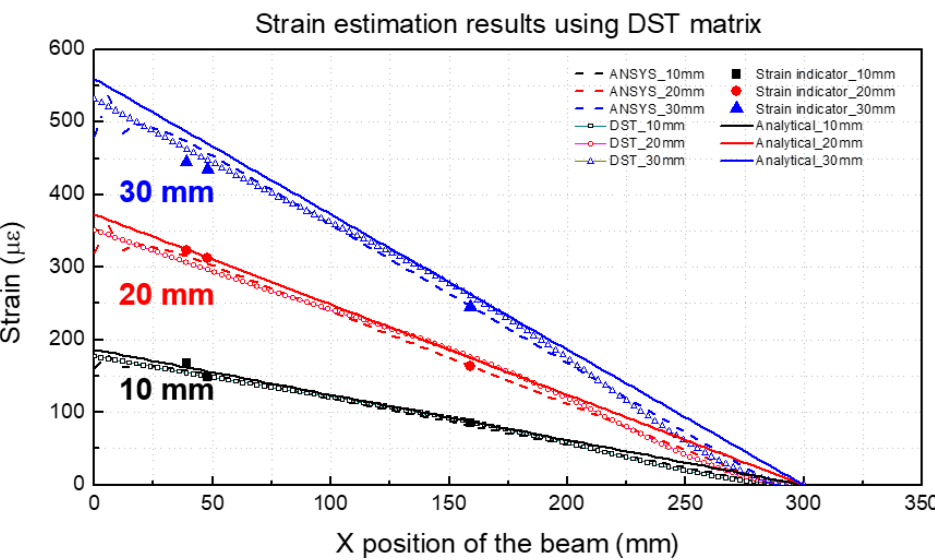
Figure 9. Strain estimation results using the DST matrix (Single material). Table 4. Strain estimation results using the DST matrix (Single material).